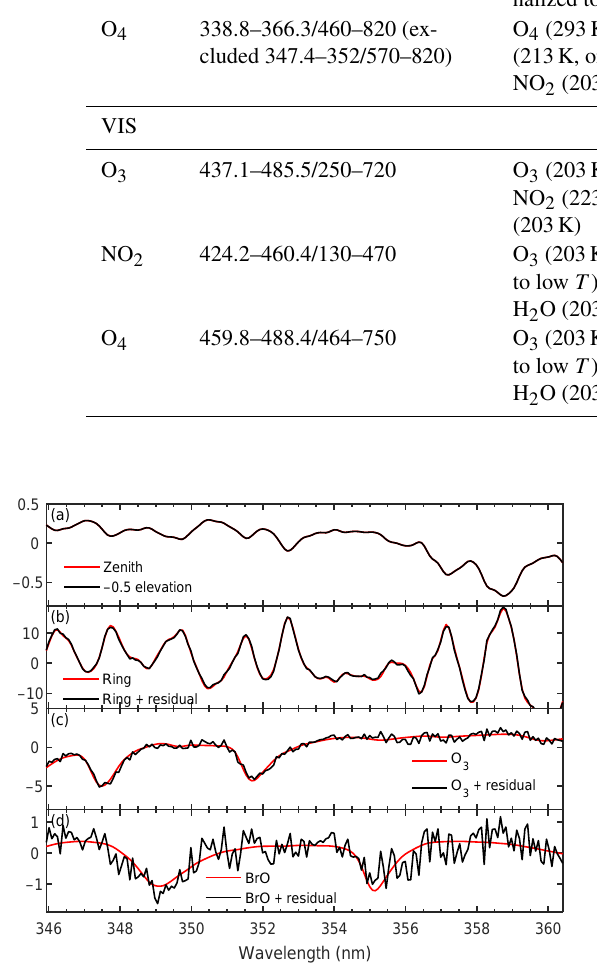
Figure 2. Example of the spectral analysis of BrO during SF3- 2013 (14 February 2013) at 20:28UT at an altitude of 17.0km at 29.8 ◦ N, 128.9 ◦ W. The original spectrum was recorded with an el- evation viewing angle of − 0.5 ◦ . Optical densities (O.D.) are in ar- bitrary units. The top panel compares the − 0.5 ◦ spectrum to the solar reference, while the second panel shows that the Ring spec- trum is the second-most prominent spectral feature in this spec- trum. Ozone was retrieved using two reference spectra for differ- ent temperatures. Panel (c) shows the sum of these two absorption spectra compared to this sum added to the fit residual. Panel (d) shows the comparison of the absorption of BrO for a DSCD of ( 1 . 94 ± 0 . 19 ) × 10 14 moleccm − 2 . The two BrO absorption bands are clearly identified in this